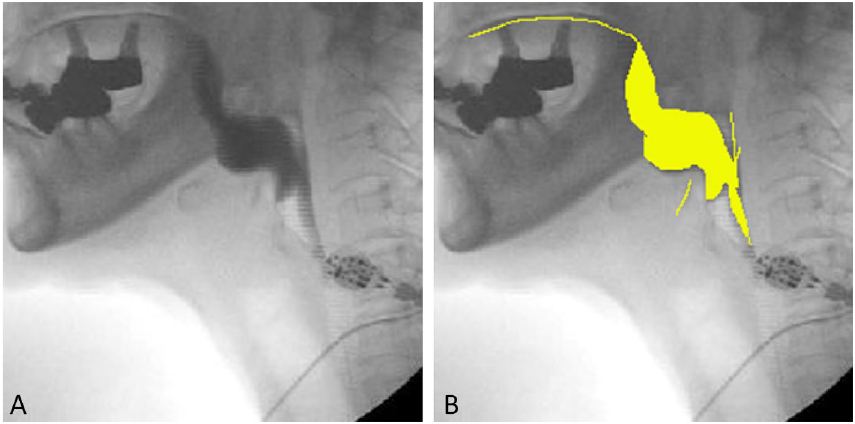
Figure 4. Annotation using training and verification datasets. ( A ) Original image. ( B ) Image in which contrast- enhanced bolus areas were colored.